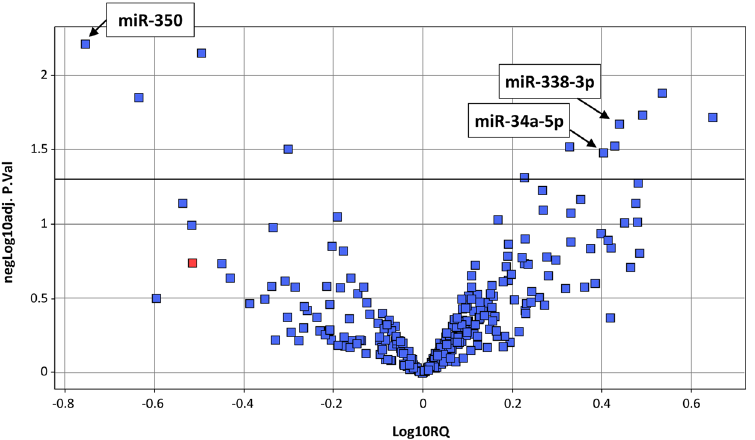
Figure 1. Volcano plot showing the results of the miRNA profile analysis in liver samples of wt and PA mouse. Following qRT-PCR, Ct values were assigned using the SDS2.4 software (Applied Biosystems, Thermo-Fischer) and Ct values above 37,0 were considered as non-detected. MicroRNAs showing very low responses (Ct > 35) in most of the samples of both groups were also removed for further analysis. Finally, Ct values were analyzed using the StatMiner software (Integromics, Perkin-Elmer). The integrated GeNorm software was used to check the stability of putative endogenous genes and a final number of seven was used for normalization (see materials & methods section). Relative comparison of gene expression was made using the wt samples as the reference for the Pcca − / − (A138T) group and the geometric mean of selected endogenous genes for normalization. Individual RQ (relative quantity) values as well as statistical p values were calculated for the detected 286 miRNAs and represented in log10 scale in the form of a volcano plot.